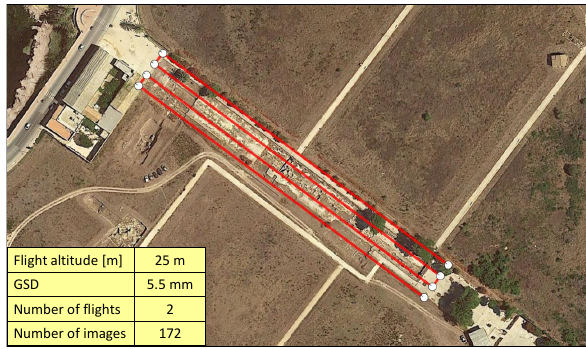
Figure 5. Flight specifications for the Decumanus maximus